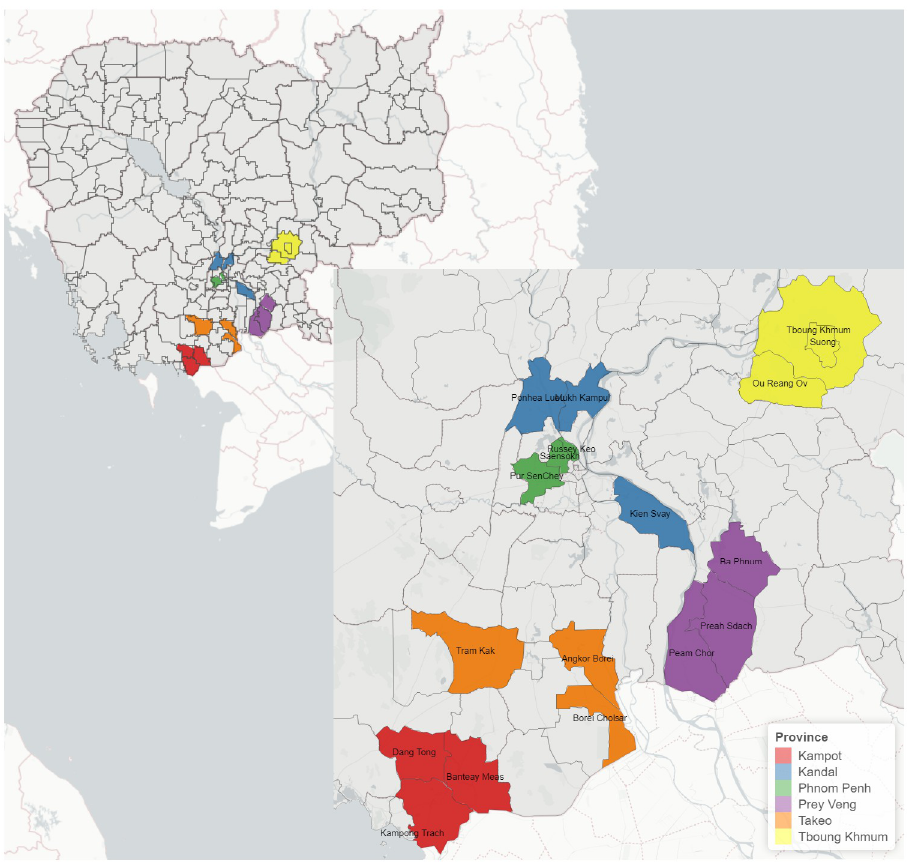
Fig 2. Sample collection locations in Cambodia. Map shapefiles sourced from https://www.diva-gis.org/gdata.